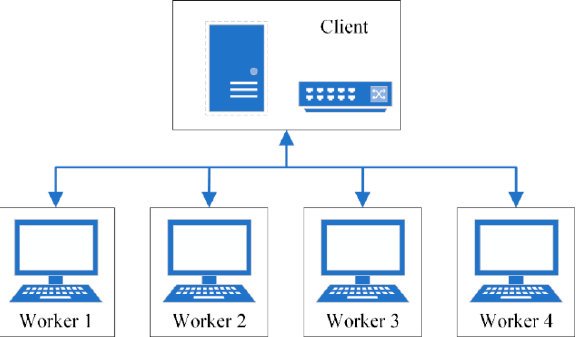
Figure 2. The PCT distributed simulation verification system architecture.